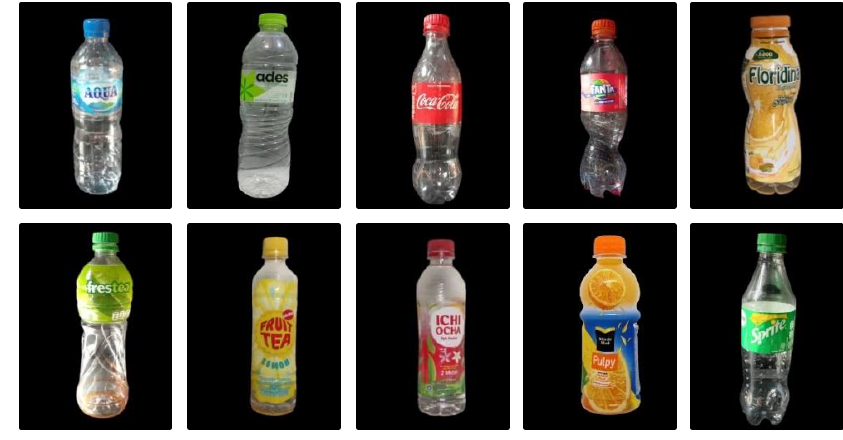
Figure 1. Sample Image Data of Plastic